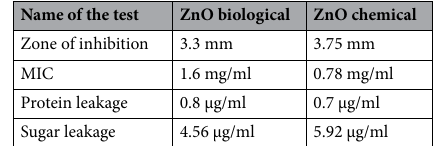
Table 3. Comparative analysis of the synthesized nanoparticles and chemical nanoparticles.